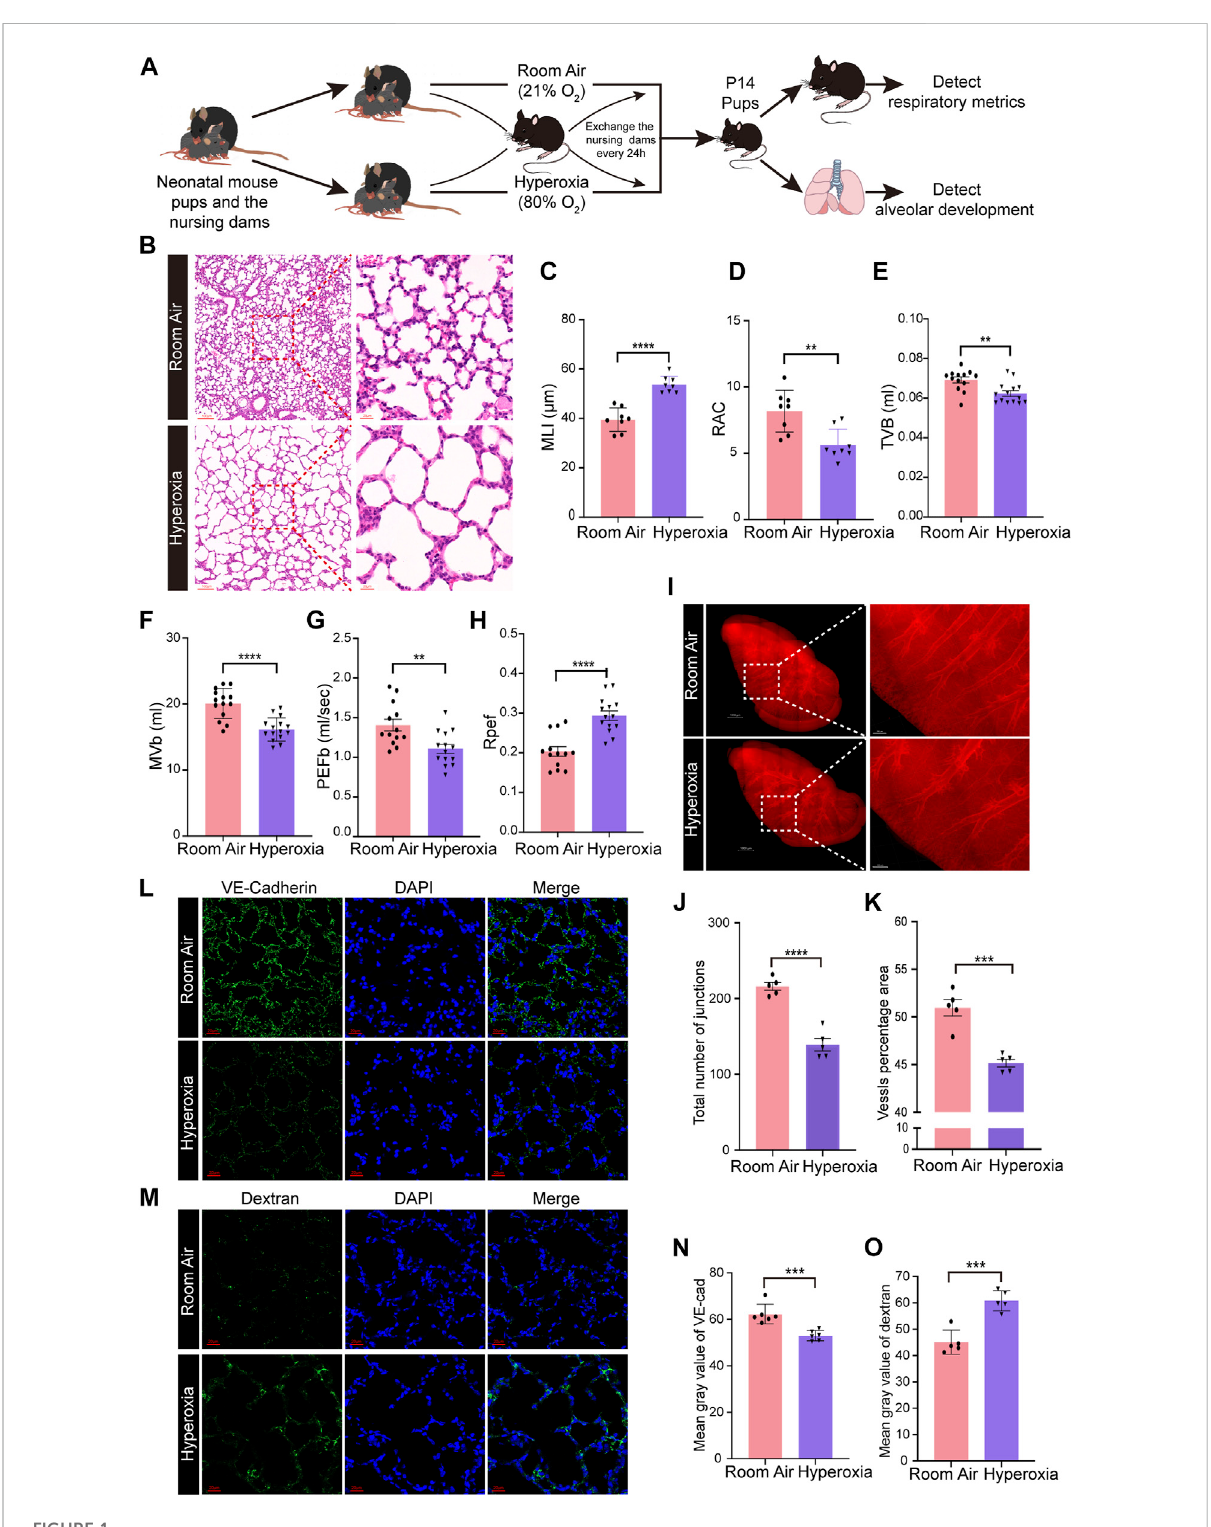
Hyperoxia disrupted angiogenesis and alveologenesis and resulted in respiratory dysfunction inneonatal mice. (A) Approach to develop a mouse model of BPD. Mouse pups were exposed to room air (21% O 2 ) or hyperoxia (80% O 2 ) from the day of birth (P0) to postnatal days (P)14. After measuring the respiratory metrics at P14, lungs were harvested for detection. (B) Representative images of H&E-stained lungs. The left panel shows low-magni fi cation (scale bar = 100 μ m) images, and the right panel shows higher-magni fi cation (scale bar = 20 μ m) images.